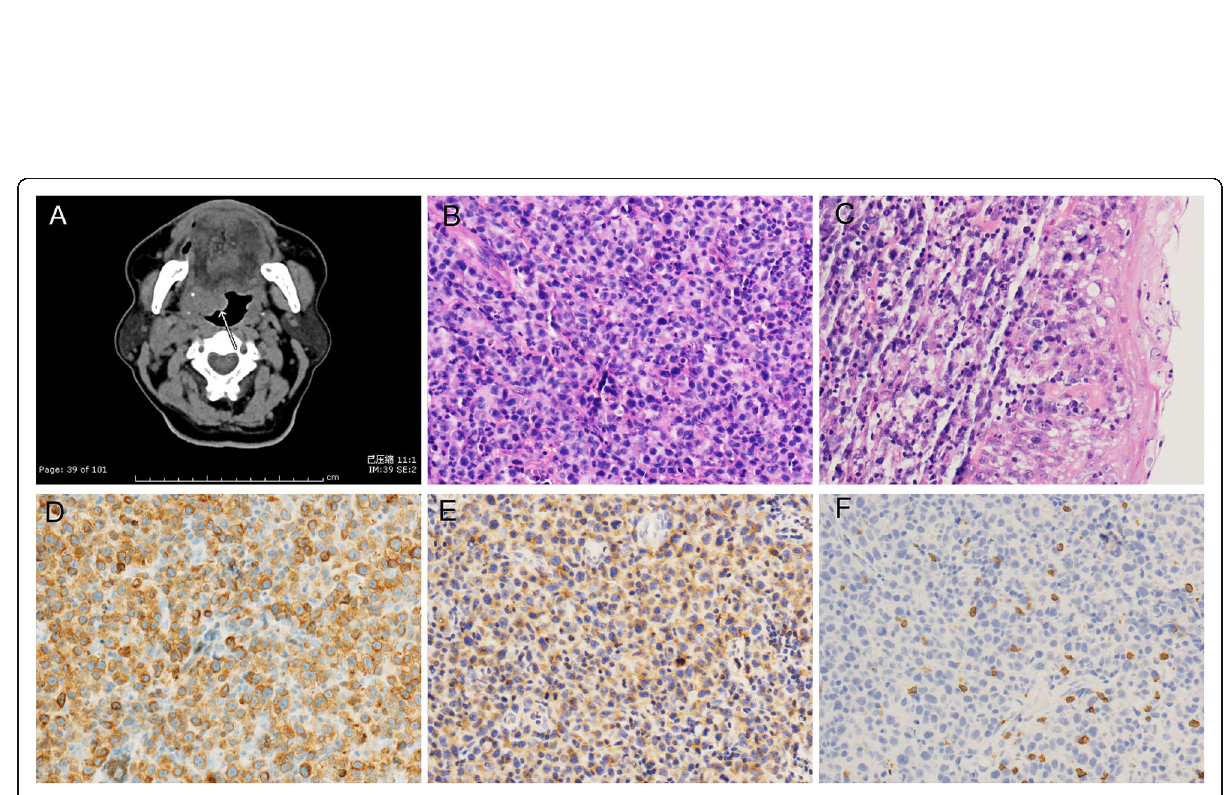
Fig. 2 The case of DLBCL showing HPV DNA positivity (case 6). a . H&E showed a diffuse infiltrate of large cells with an obvious nucleolus and abundant cytoplasm (200 x). b . Tumour cells diffusely expressed CD20 (200 x). c . Immunohistochemistry staining showed diffuse and strong staining of P16 protein (40 x) d . Immunohistochemistry staining showed diffuse and strong staining of P16 protein (100 x). e . HPV DNA ISH showed brown punctate dots in the tumour cell nucleus or cytoplasm (400x). f . HPV RNA ISH all negative